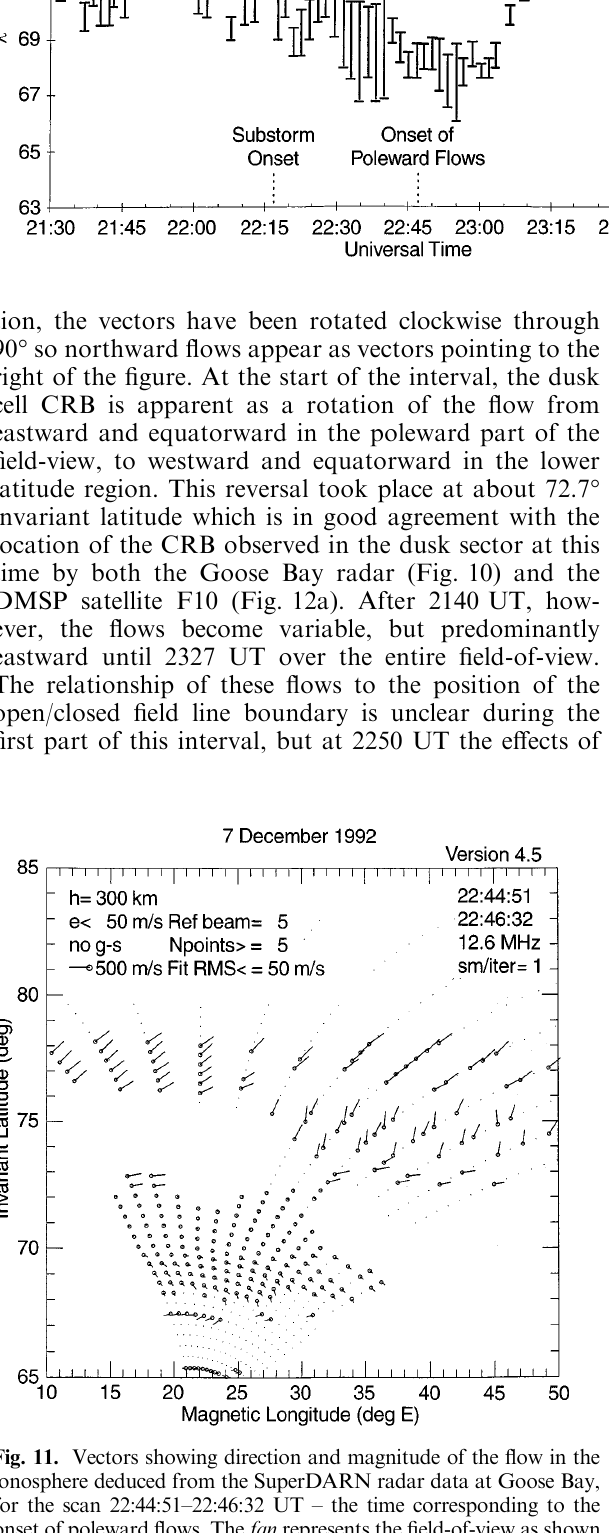
Fig. 10. Graph showing the latitudinal posi- tion of the CRB deduced from consecutive ‘‘fan’’ plots of Goose Bay data plotted against time. The latitude of the poleward UV auroral boundary is marked for Freja orbit 828 as F1 and the latitude of the CRB as determined from the DMSP-F10 data are denoted by solid triangles . The times of substorm onset and the start of enhanced poleward flows detected by the Goose Bay radar are also indicated